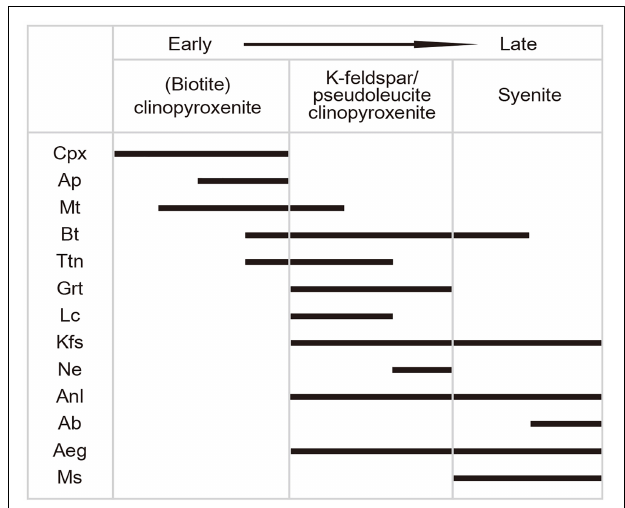
FIGURE 15 | Speculated mineral crystallization sequence of Yaojiazhuang